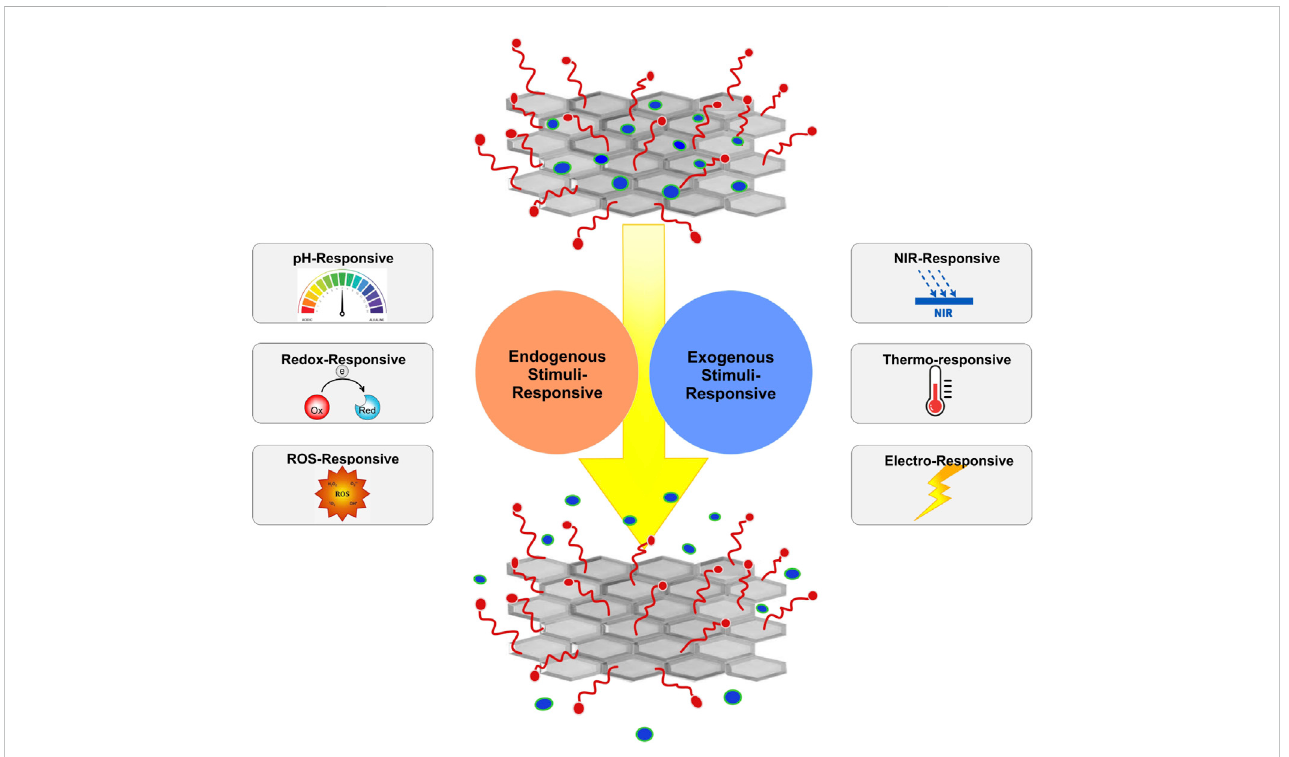
FIGURE 1 Schematic representation of stimuli-sensitive nanomaterials for the controlled delivery of therapeutic